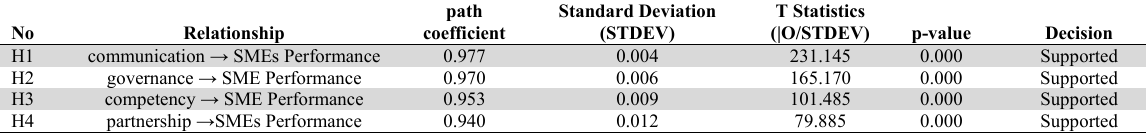
Results of Hypotheses Testing (Direct Relationship